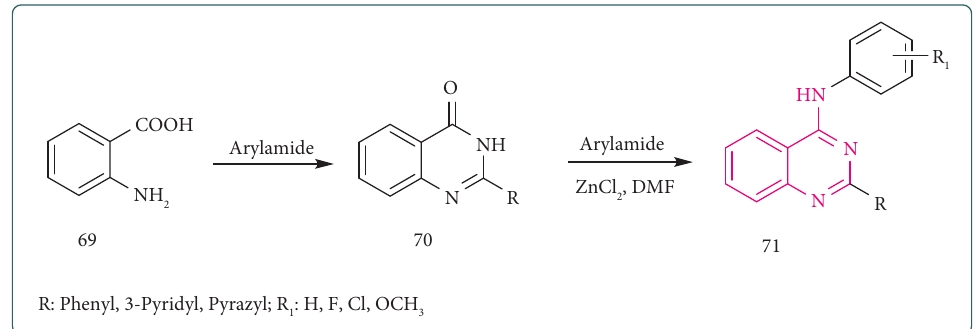
Scheme 12: Synthesis of 2,4-disubstituted quinazolines in the presence of ZnCl